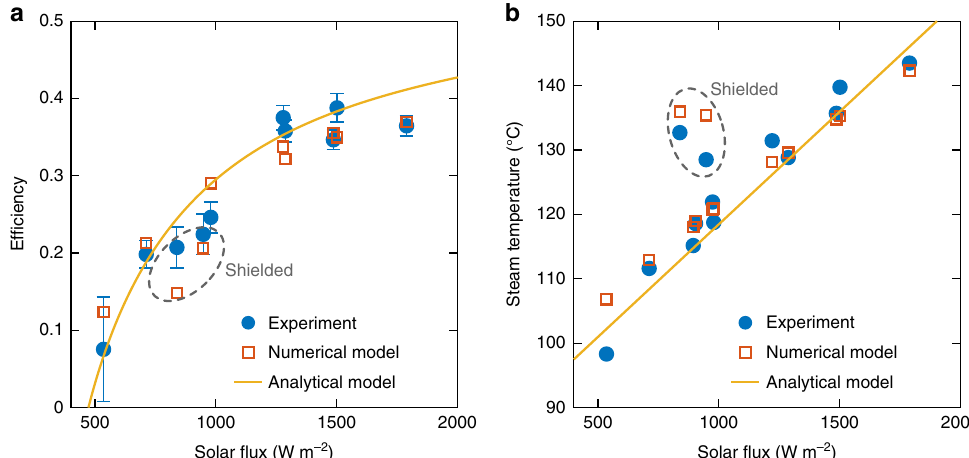
Fig. 4 Performance of a laboratory-scale contactless solar evaporation structure. a Measured and modelled steady-state ef fi ciency as a function of the incident solar fl ux. Each data point corresponds to a single unique experimental run. The steady-state ef fi ciency was determined by dividing the evaporated mass during the quasi-steady phase Δ m ss by the duration of the quasi-steady phase Δ t ss . The evaporated mass was determined by measuring change in the mass of water in the basin before and after the experiment Δ m basin . Error bars indicate uncertainty in steady-state ef fi ciency due to the small amount of evaporation in the heat-up phase (see Fig. 3) Δ m heat-up , which is attributed partially to evaporation from the basin, and partially to evaporation of residual moisture in the system. For the lower bound, Δ m heat-up is attributed solely to basin evaporation, is thus subtracted from Δ m basin to obtain a rigorous lower bound on ef fi ciency. For the upper bound, Δ m heat-up is attributed entirely to residual moisture and thus does not need to be subtracted from Δ m basin . The marker location indicates a representative intermediate value where we attribute 50% of Δ m heat-up as being due to basin evaporation (see Supplementary Note 11 for details). b Measured and modelled superheated steam temperature during the quasi-steady region as a function of the incident solar fl ux. The analytical model is described in Supplementary Note 3, and is summarized by Eqs. (5) and (6). The numerical model is described in Supplementary Note 5. For the results labelled “ shielded ” , a radiation shield was used to boost the steam